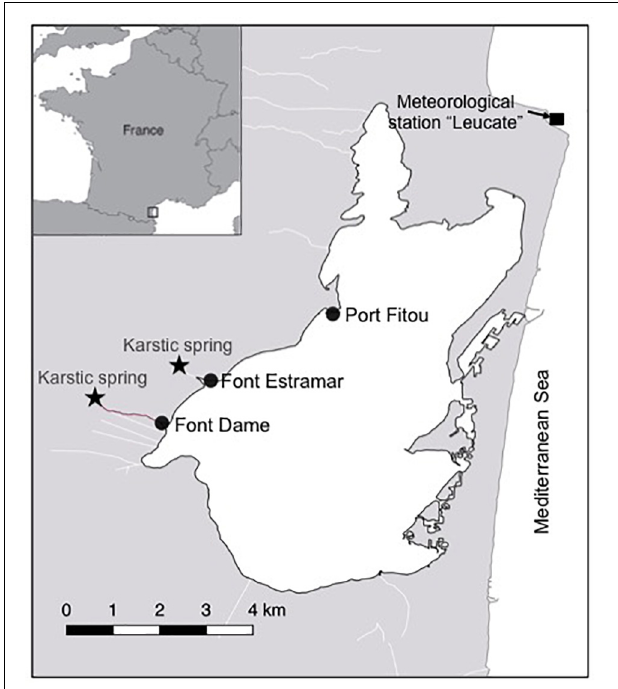
FIGURE 1 | Salses-Leucate lagoon location on the French Mediterranean coastline. The groundwater-influenced sites (Font Dame and Font Estramar) and control site (Port Fitou) are shown, as well as the groundwater springs and the meteorological station.